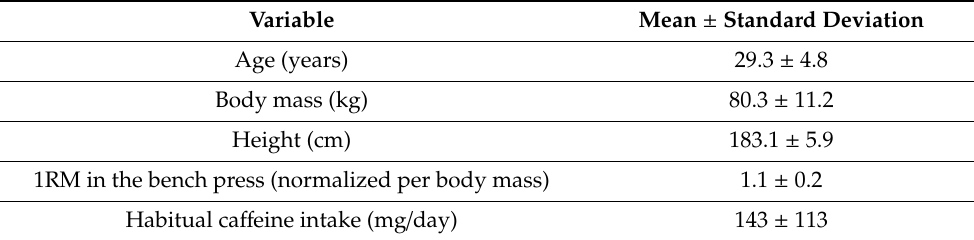
Table 1. Characteristics of the